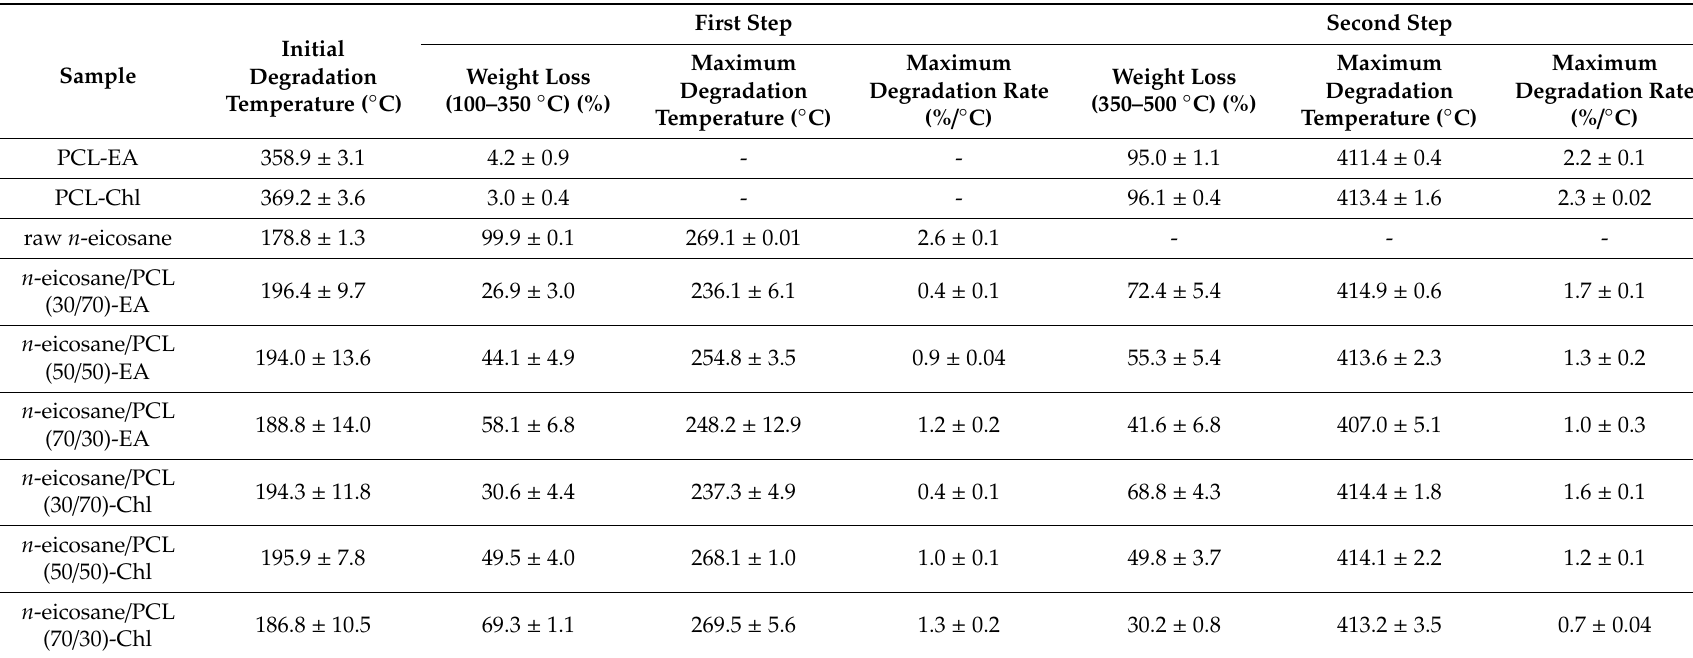
Table 4. Thermogravimetric data for of n -eicosanee, neat PCL microsphere and n -eicosane microcapsules in inert atmosphere at a heating rate of 10 ◦ C · min − 1